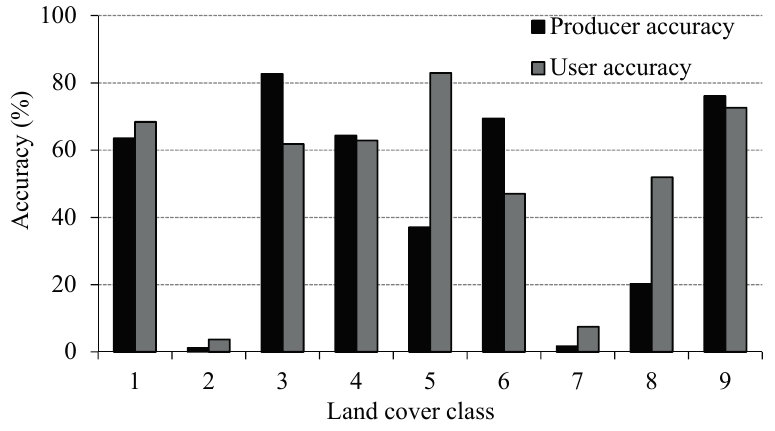
Figure 7. Comparison of the producer and user accuracies in a sub-pixel confusion matrix based on a generalized